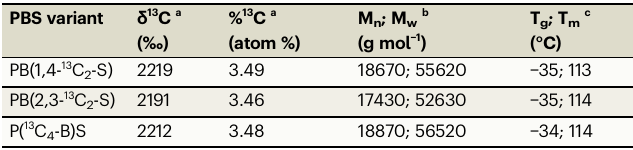
Table 1 | Carbon-isotopic composition and key physico- chemical properties of the three 13 C-labelled poly(butylene succinate) (PBS) variants used in soil